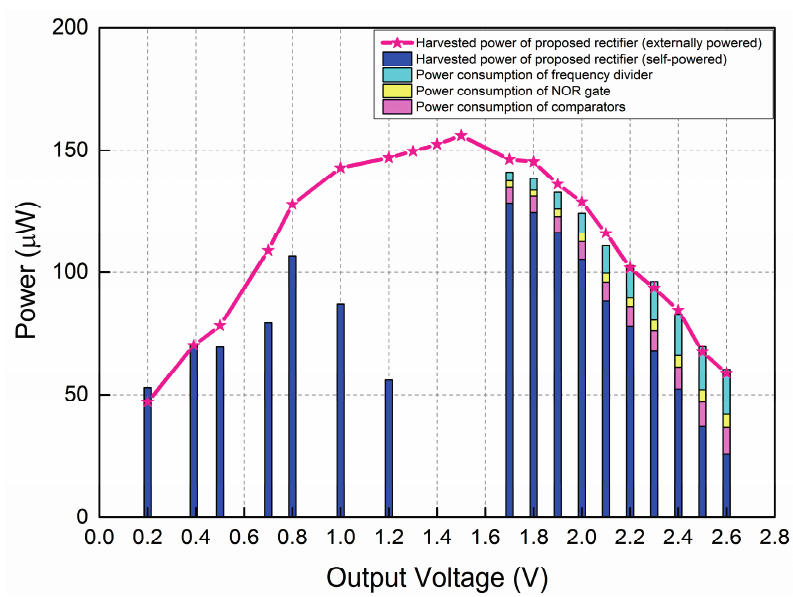
Figure 10. Power measurements of control circuit elements against output power of proposed